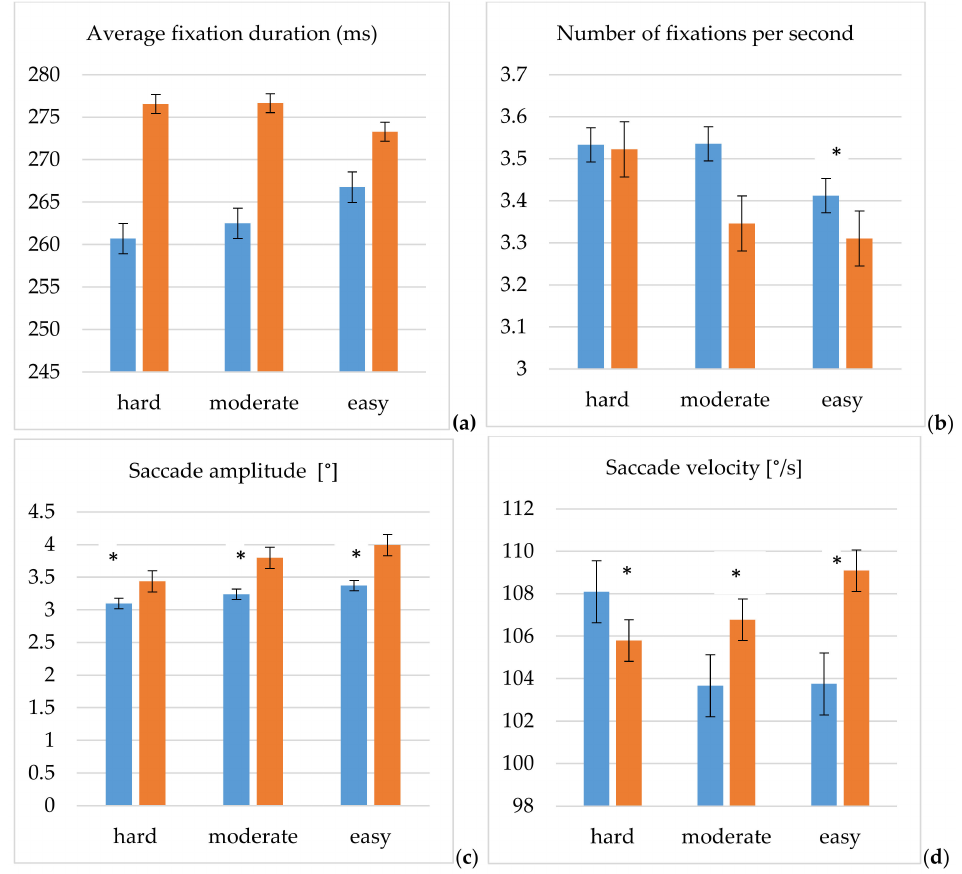
Figure 5. ( a ) Fixation duration; ( b ) number of fixations per second (also published in [6]); ( c ) saccade amplitude, ( d ) saccade velocity (blue bars: experts, orange bars: novices, *: significant di ff